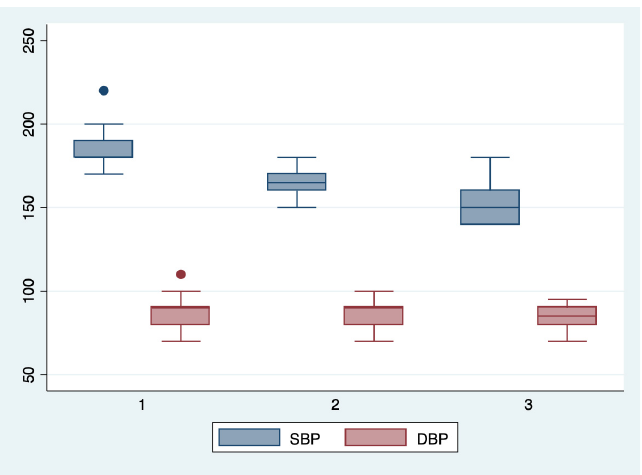
Figure 4. Boxplot representing the comparison of the systolic and diastolic blood pressures in the subgroups 1, 2, and 3. Legend: SBP—systolic blood pressure; DBP—diastolic blood pressure.